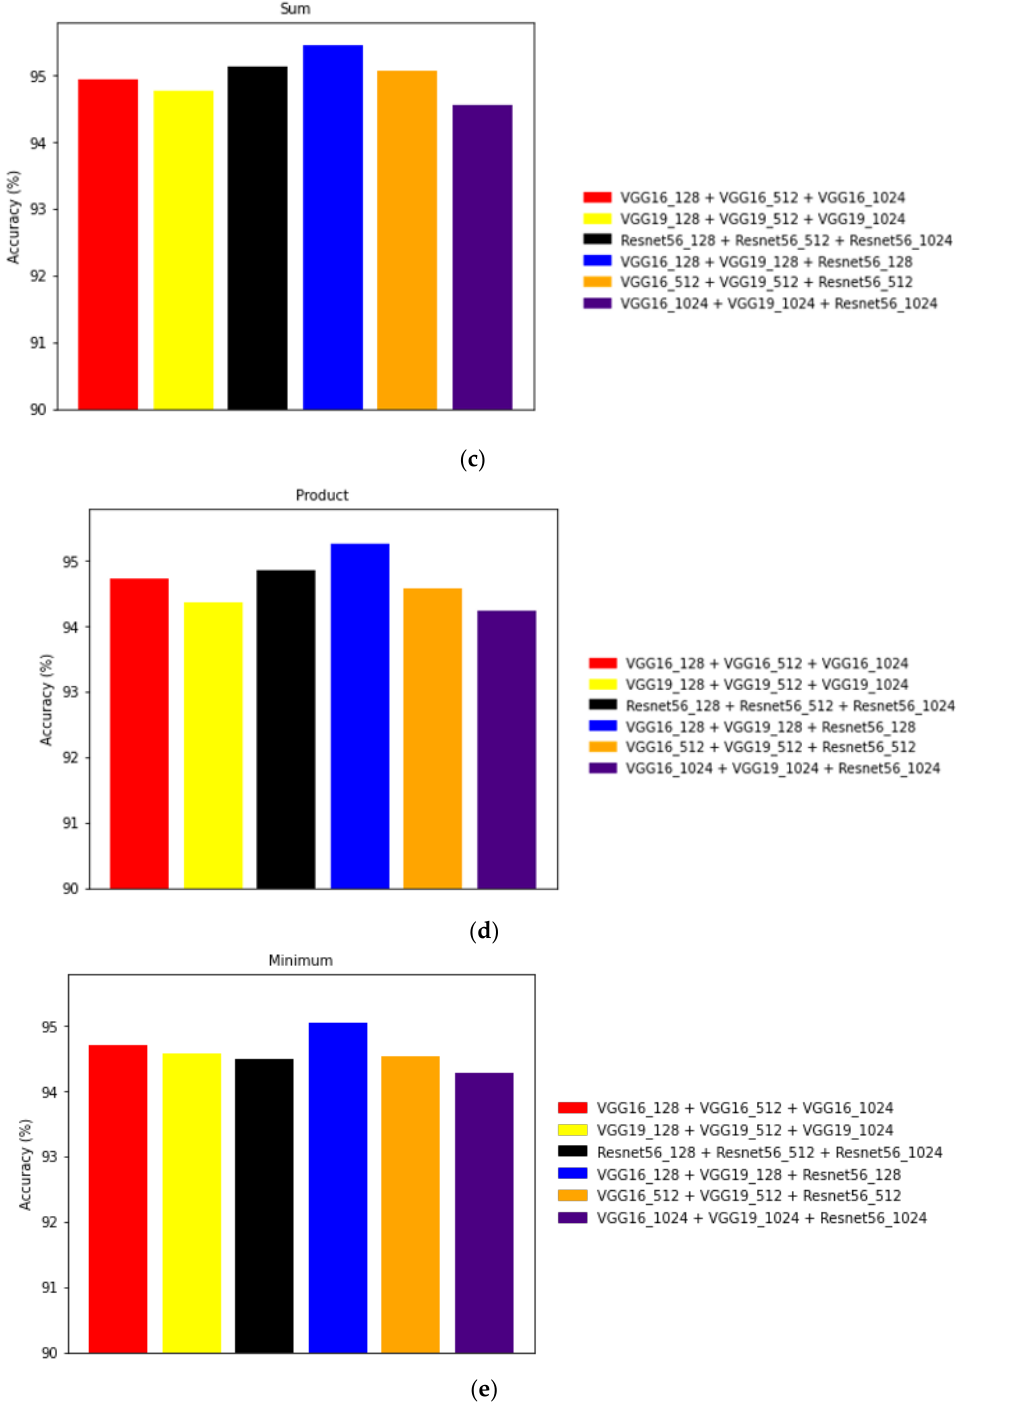
Figure 9. ( a – e ): Accuracy with different model combinations for each fusion strategy.